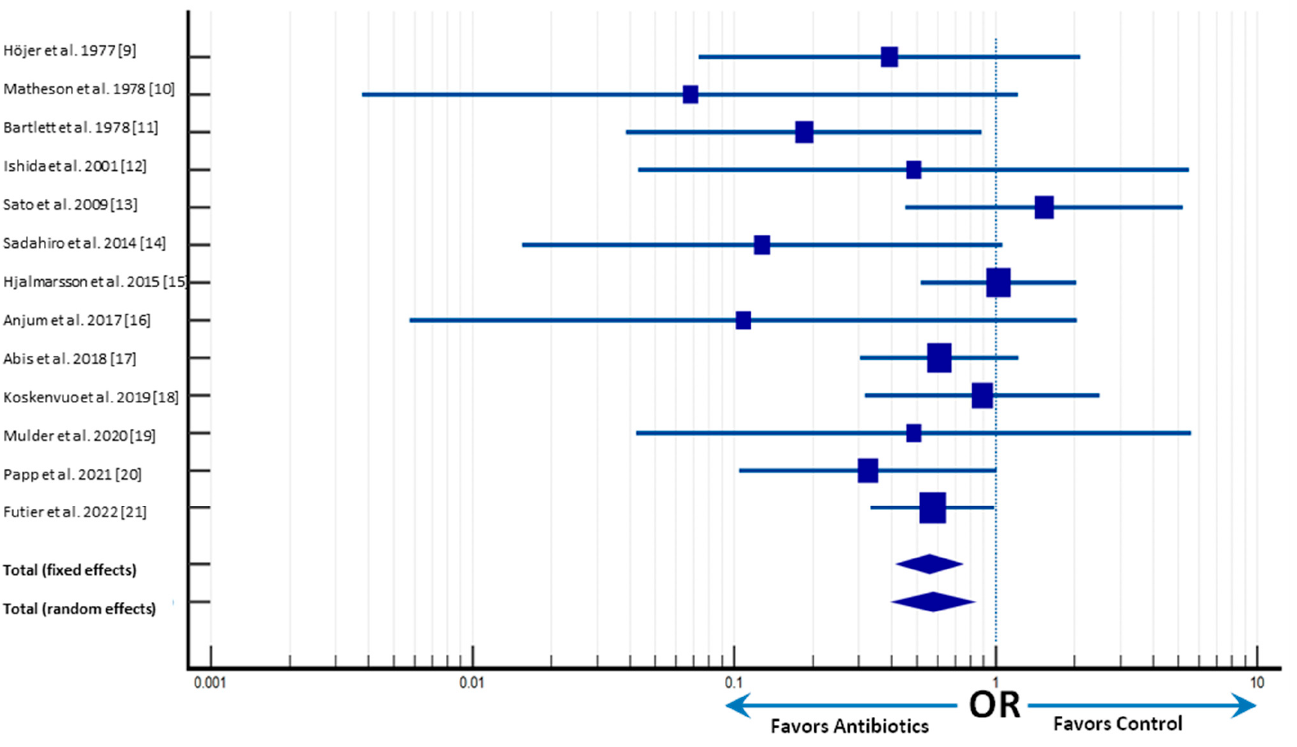
Figure 4. Forster plot of anastomotic leak rates. Odds ratio (OR) and 95% confidence intervals (CI).